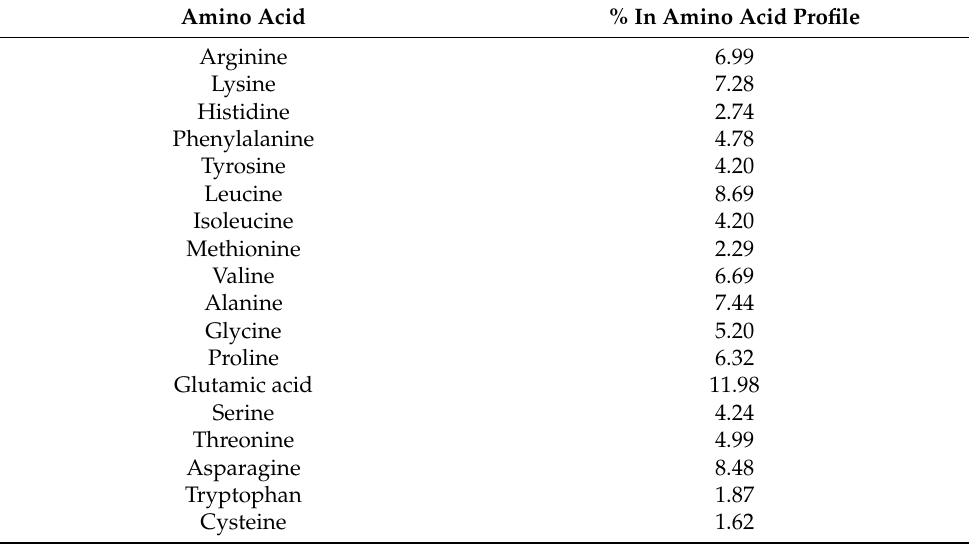
Table 2. Amino acids profile (%) of Euglena gracilis .